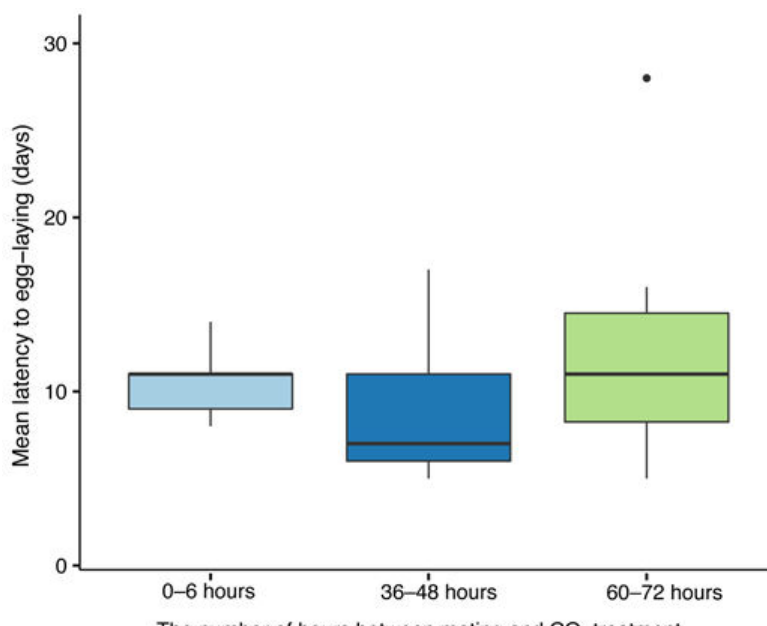
Figure 3. The impact of CO 2 treatment on the latency to lay eggs in Bombus impatiens queens. Queens ( n = 26) were treated with CO 2 at three time points after mating: 0–6 h ( n = 9); 36–48 h ( n = 9); 60–72 h ( n = 8). Queens were monitored for egg laying for 28 days. Boxplots represent the minimum, lower quartile, median (bolded line), upper quartile, and maximum values; points represent